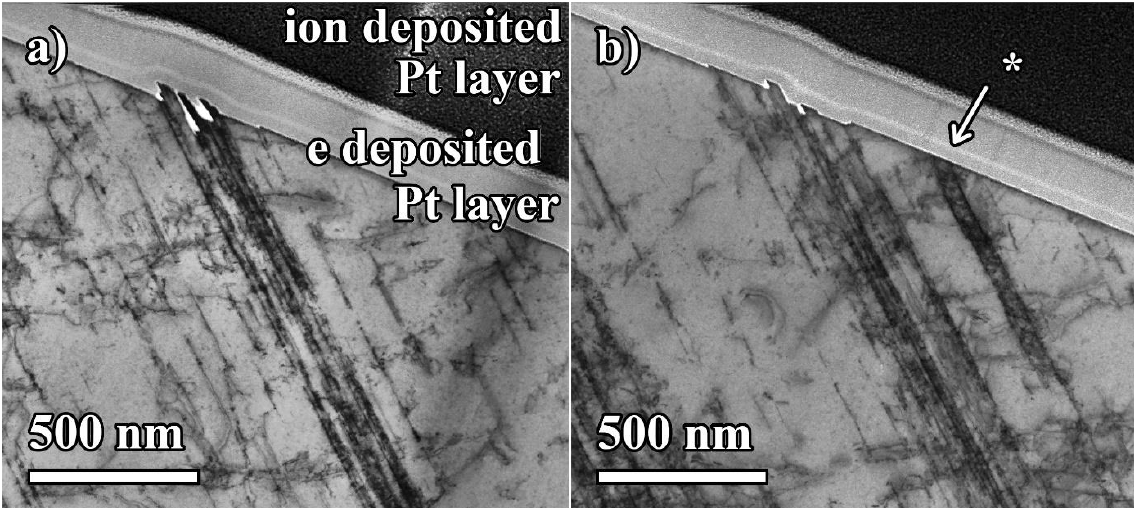
Figure 7. STEM micrographs of solution treated superalloy RENE 41 after 30 cycles with strain amplitude ε a = 8 × 10 −3 , ( a ) PSM consisting of extrusions and intrusions on the top of the band of pronounced localization in the PSB, ( b ) slip steps producing small extrusion and intrusion on the surface. The mark ( * ) highlights the band producing no surface relief in the particular section.